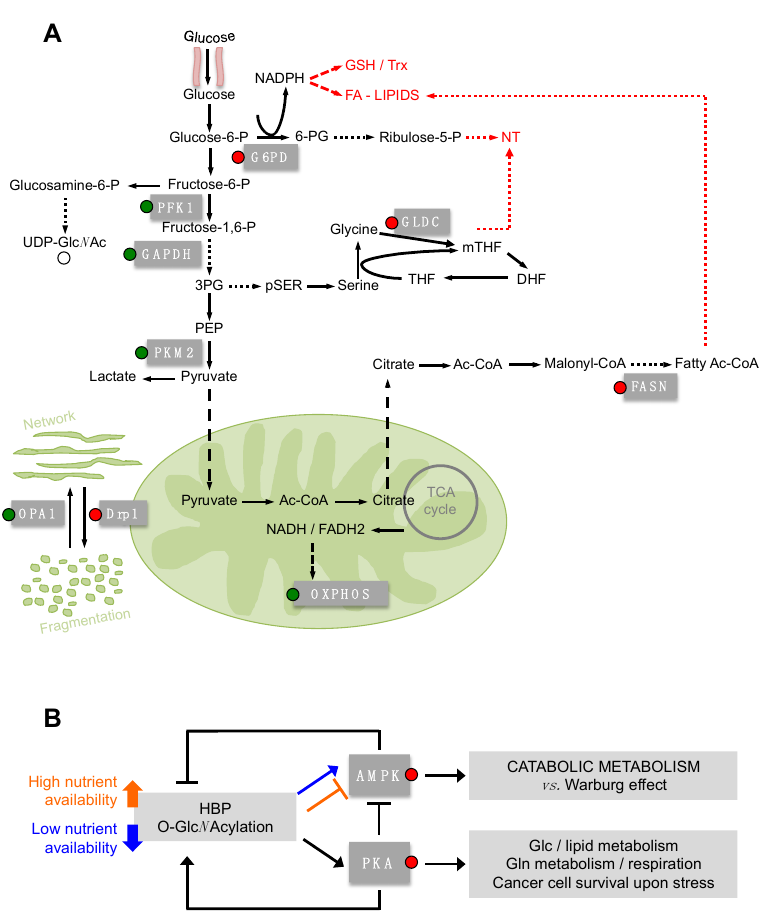
Figure 3. HBP modulates cancer metabolism through the O -Glc N Acylation of metabolic enzymes, signaling proteins and mitochondrial proteins. ( A ) In the image, the main metabolic pathways exploited by cancer cells for anabolism and bioenergetics are represented. The O -Glc N Acylated proteins (mainly the metabolic enzymes) are indicated in the grey boxes if the effect of the glycosylation has been demonstrated. The circle on the box, representing the O -Glc N Acylation, is red when the protein function is activated by glycosylation and green when it is inhibited. ( B ) The reciprocal regulation of AMPK and PKA and the HBP is schematically represented as discussed in the main text. 6-PG, 6-phosphogluconate; 3-PG, 3-phosphoglycerate; PEP, phosphoenolpyruvate; THF, tetrahydrofolate; DHF, dihydrofolate; FA, fatty acids; Fatty Ac-CoA, Fatty Acyl-Coenzyme A; GSH, glutathione; Trx, thioredoxin; NT, nucleotides. GAPDH is modified by O- Glc N Acylation mainly at Thr172. This modification favors the oligomeric instead of the tetrameric form of the enzyme, leading to its translocation into the nucleus and to the biological activities mediated by the non-tetrameric GAPDH [99]. Indeed, while the glycolytic activity is exerted by the cytoplasmic tetrameric GAPDH, the oligomeric nuclear form of the enzyme has roles in the transcriptional control of histone gene expression, fusion of the nuclear membrane, DNA repair and maintenance of the telomere structure [100]. Although the impact of the GAPDH O- Glc N Acylation on cell metabolism has not been deeply investigated, the functional redirection of the enzyme could lead to a decrease in the aerobic glycolysis, enhancing the flux through the glycolytic branches. This might be in accordance with the effect observed for PFK1 and PKM2 O- Glc N Acylation, which directly controls their glycolytic enzymatic activity, leading to blocking the binding of the allosteric activator fructose-2,6-bisphosphate (F-2,6-BP) and thereby